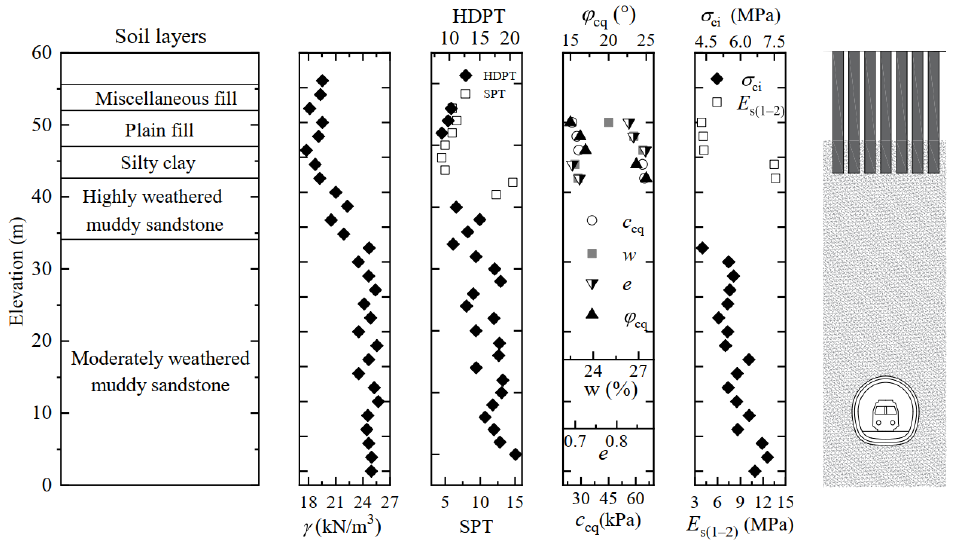
Figure 3. Geotechnical profile and properties of soil and rock.